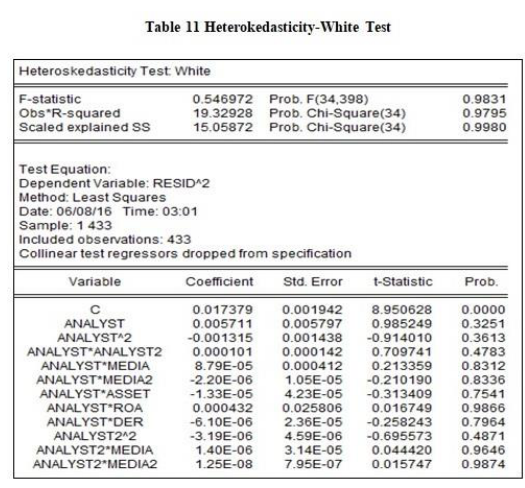
Table 11 Heterokedasticity-White